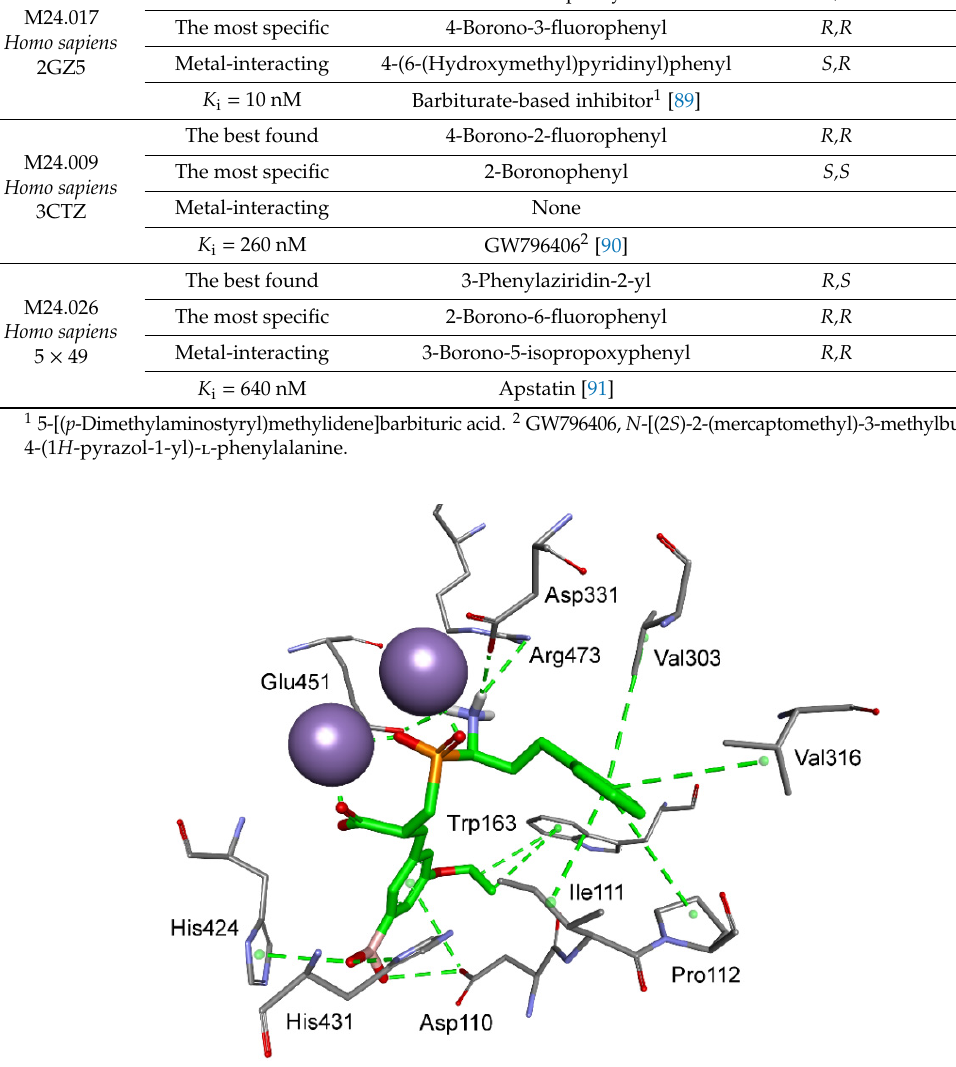
Figure 6. Modeled binding mode of a phosphinic dipeptide analog containing a 3-borono-5- isopropoxyphenyl P1 ′ fragment in the active center of aminopeptidase P3 (PDB: 5 × 49). Amino acid residues of the inhibitor and enzyme are shown as sticks, while cobalt ions are shown as purple spheres. Hydrogen bonds and nonpolar interactions are shown as thin dashed lines.